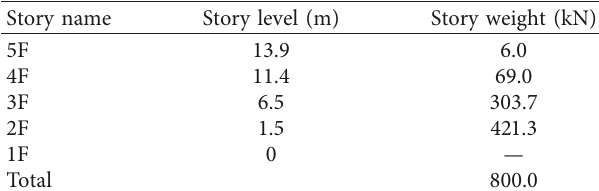
Table 1: Lighthouse story weight.